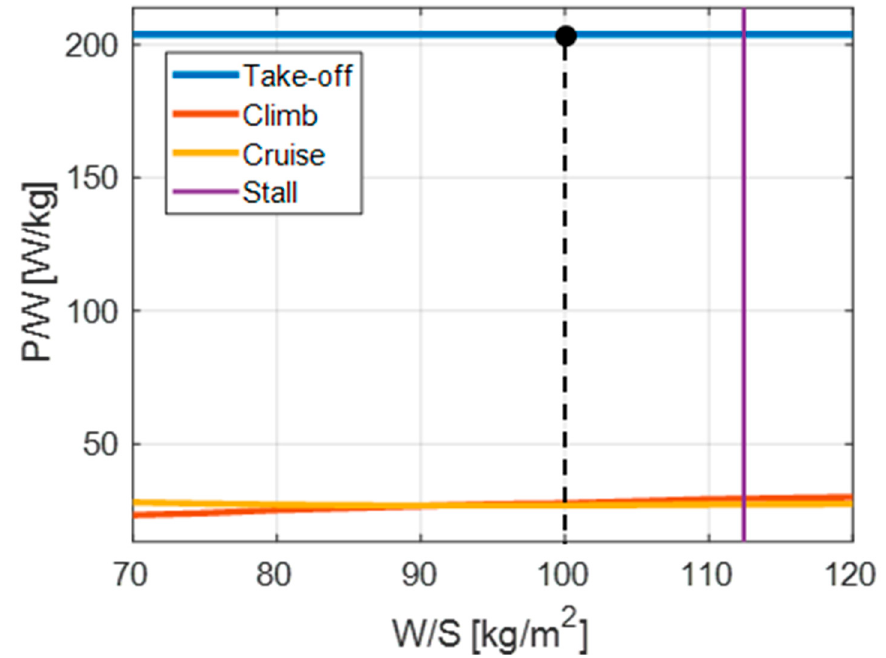
Figure 6. Example of matching chart of the TiltOne .